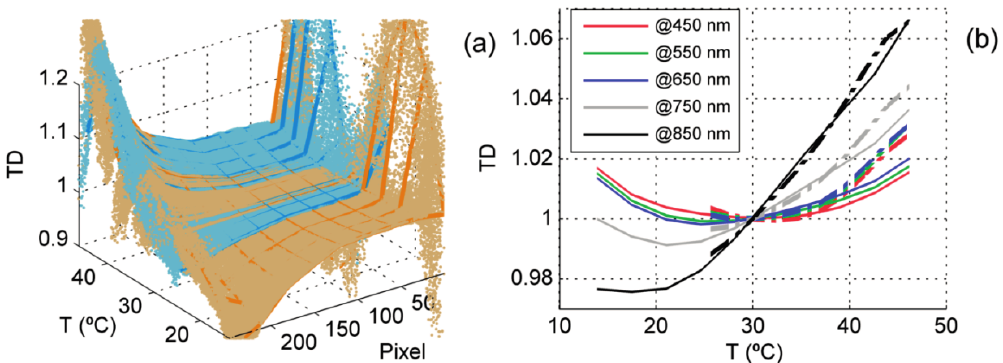
Figure 3. Temperature dependence models in channel 1: ( a ) Warm-up model and data (in orange) cool-down model and data (in blue). ( b ) Warm-up (thin solid lines) and cool- down models (thick dashed lines) for pixels close to different wavelengths.